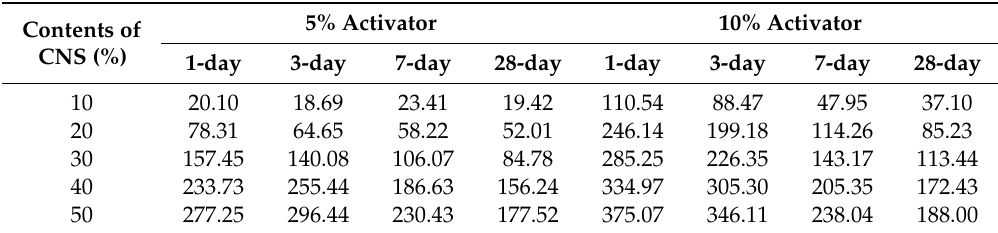
Table 3. Relative strength change rate compared to without CNS sample.